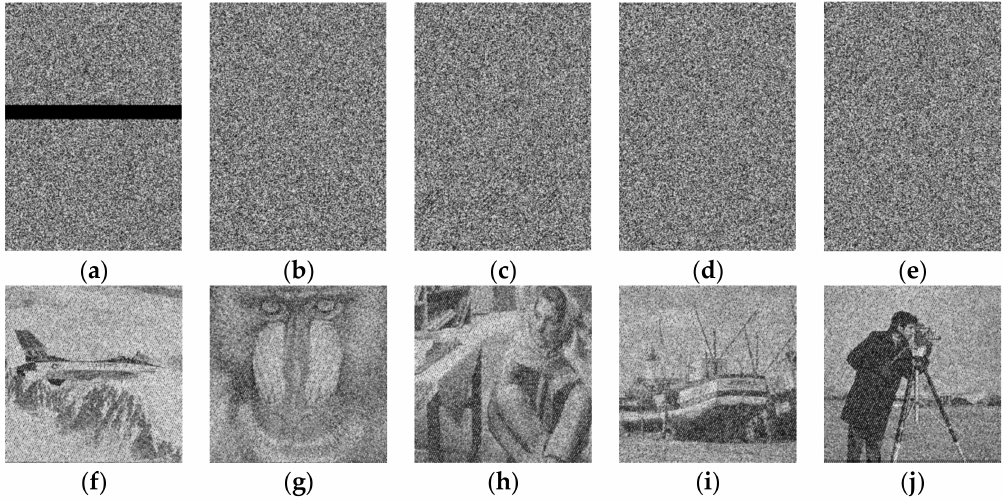
Figure 7. An example of collecting 5 shared images with one attacked shared image in a (5, 4, {2, 3, 4, 5}) XOR-based progressively secret image sharing, ( a ) the attacked shared image, ( b – e ) the correct shared images, ( f – j ) the recover results by using ( a – e ).